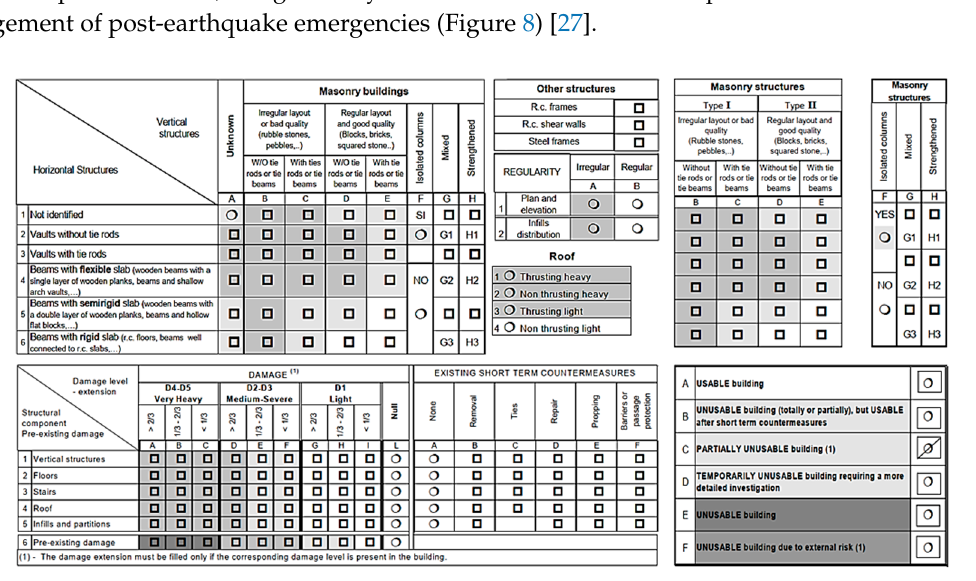
Figure 8. Framework of the main section of the Post-Earthquake Damage and Safety Assessment (AeDES) form.